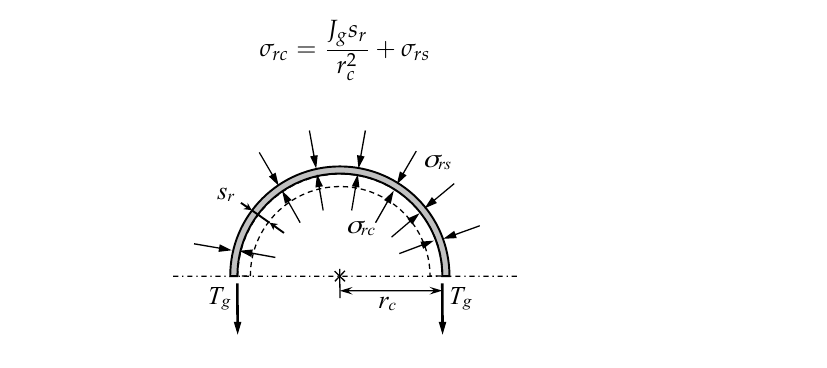
Figure 4. Equilibrium and compatibility conditions for the geosynthetic surrounding an encased stone column.